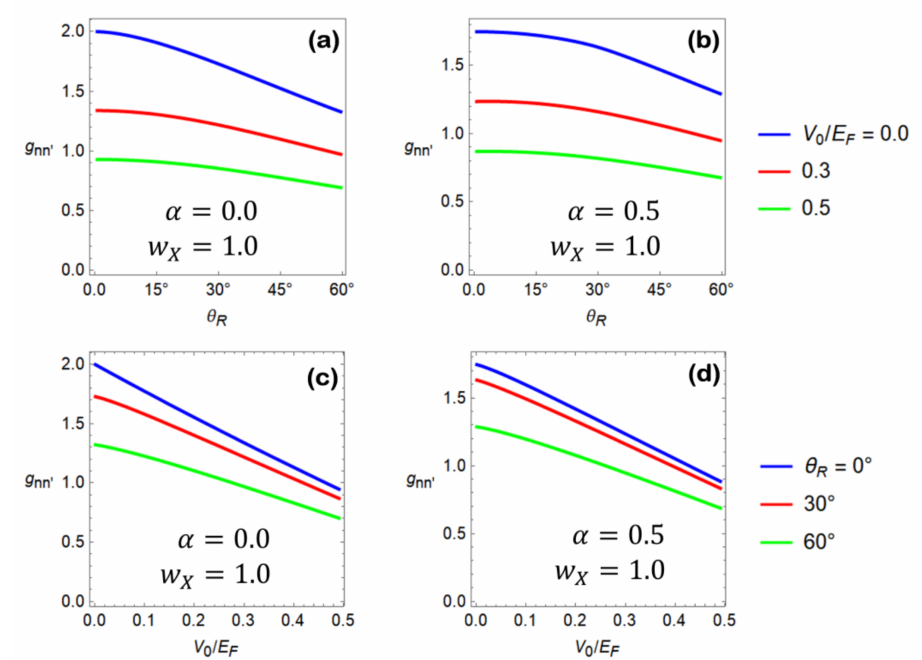
Figure 6. ( a , b ) Dimensionless differential conductance g nn (cid:48) as a function of the misorientation angle θ R . Different curves pertain to different values of the intensity of the potential step, as indicated in the figures legend. Matching matrix parameters α = 0 and α = 0.5 are used in the computation of panel ( a ) and ( b ), respectively. ( c ), ( d ) Dimensionless differential conductance g nn (cid:48) as a function of the potential step intensity V 0 . Different curves pertain to different values of the misorientation angle, as indicated in the figures legend. Panel ( c ) is obtained by fixing α = 0, while panel ( d ) is obtained by fixing α =